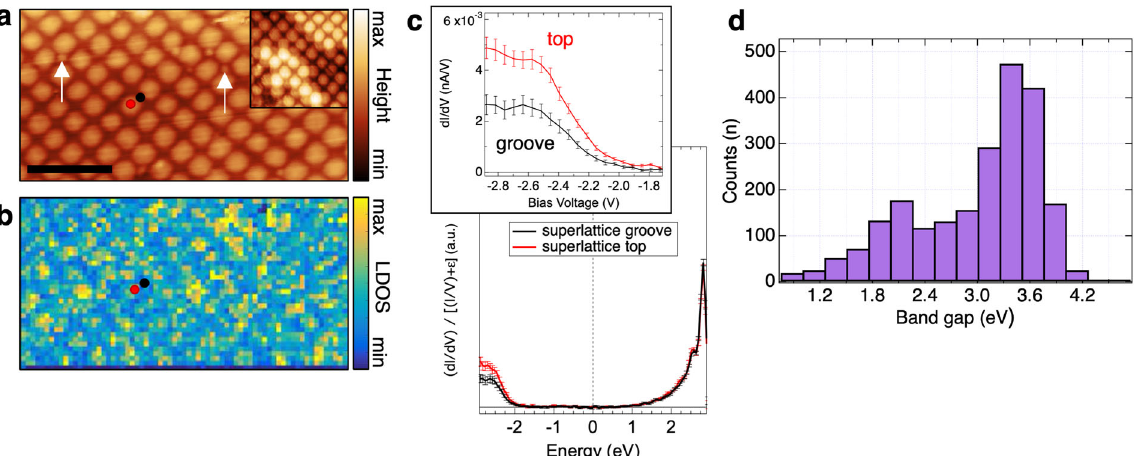
Fig. 6 Electronic heterogeneity of the NiO superlattice. Panel ( a ) is the topography image of the NiO – NiCr(100) superlattice structure and ( b ) the corresponding normalized d I /d V map (proportional to LDOS) at V slice = − 2.7 V. The image inset in ( a ) shows the orientation of the next NiO layer and is from a Ni – 12 wt%Cr(100) sample shown here for comparison (image size 20 × 20 nm 2 ). The white arrows point to small protrusions in the NiO positioned over the groove site of the superlattice. The red and black dots in the LDOS map represent the superlattice top site and the groove site, respectively, where the average, normalized d I /d V spectra shown in ( c ) were acquired. The inset above the normalized spectra shows the difference in the differential conductance of the respective sites. Panel ( d ) is a distribution of the band gap values extracted from the entire LDOS map shown in ( b ). Imaging conditions: ( a ) V bias = 2.0 V, I t = 0.1 nA, and the inset at V bias = − 1.0 V, I t = 0.1 nA. The scale bar is 10 nm. The error bars in ( c ) were calculated using standard surface re fl ects the registry of the superlattice: averaged STS point spectra (~20 curves) comparing the groove sites (black dot) with